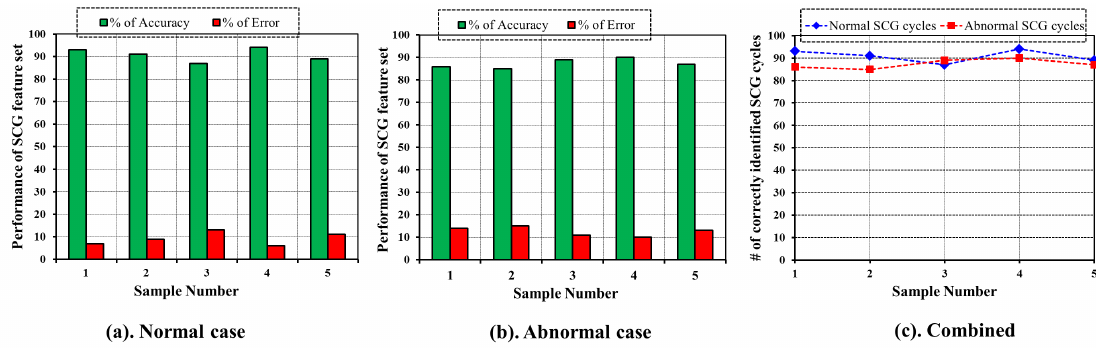
Figure 19. Performance evaluation of SCG feature set ( a ) with respect to normal SCG cycles; ( b ) with respect to abnormal SCG cycles; ( c ) Combination of ECG and SCG